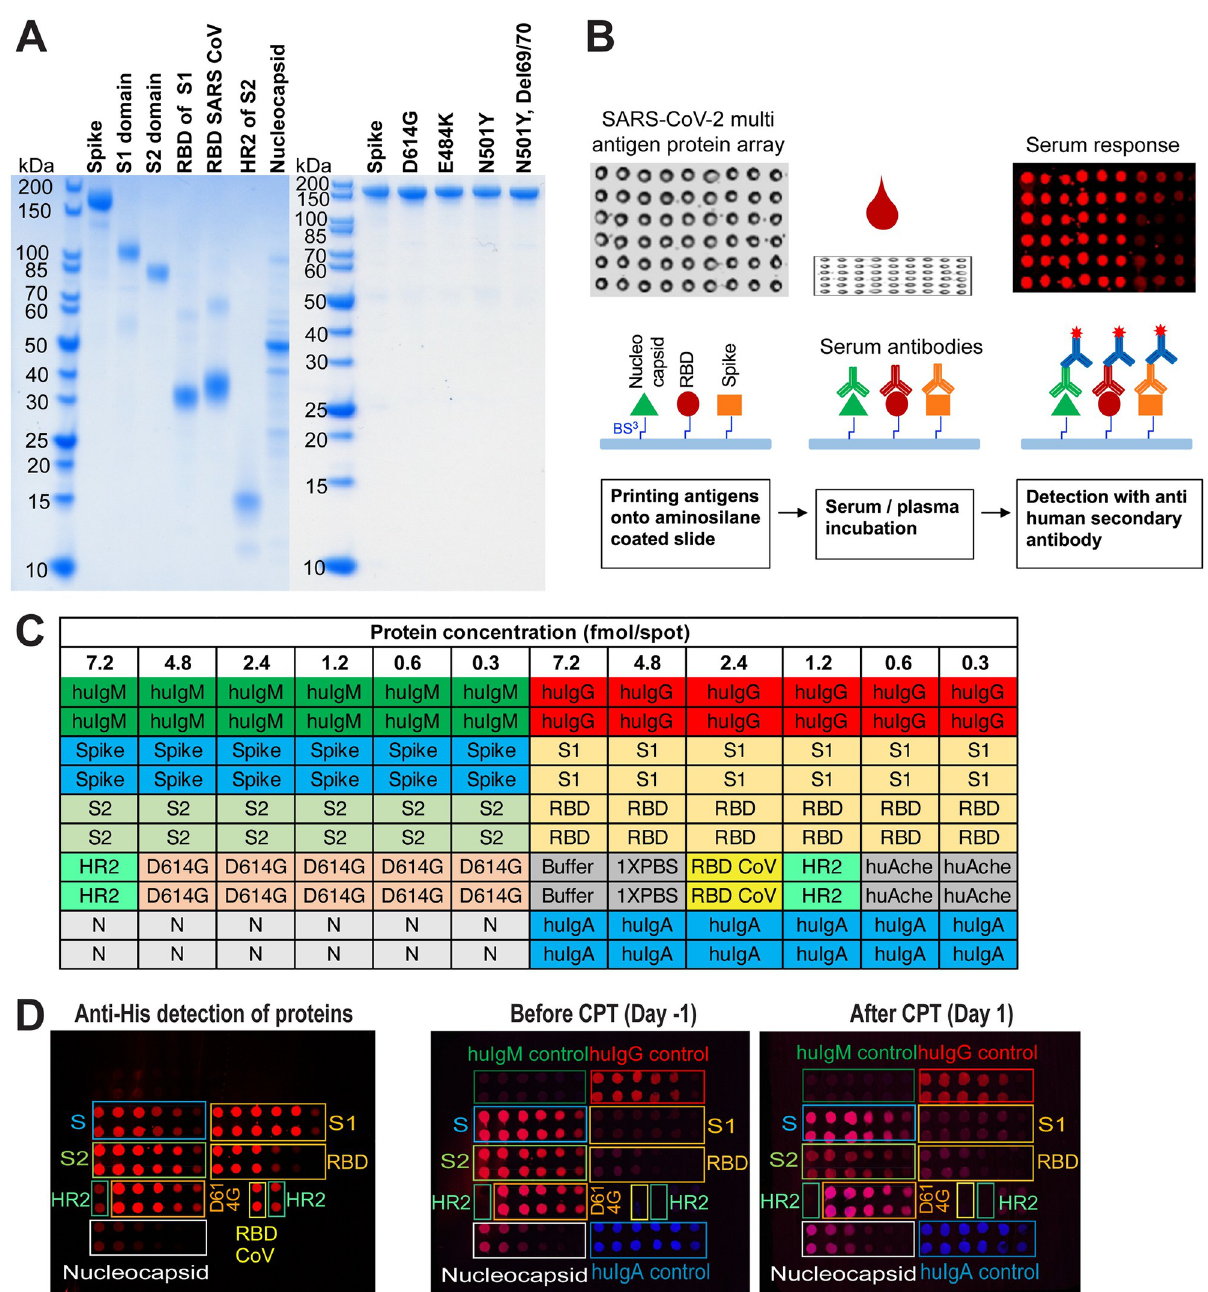
Fig 1. SARS-CoV-2 multi-antigen protein array production and processing. (A) Purified array proteins analyzed by SDS-PAGE under reducing conditions. (B) Schematics of workflow. (C) A representative protein array template showing SARS-CoV-2 antigen target proteins, human immunoglobulin controls (huIgM, huIgG, huIgA), buffer and negative controls along with the protein amounts and duplicates of each sample. (D) Anti-his staining of antigen target proteins immobilized on the microarray slide, and serum antibody detection of a COVID-19 patient one day before (Day -1) and one day after (Day 1) convalescent plasma transfusion using secondary antibodies for IgG (red) and IgA (blue) (two-color image). huIg control proteins do not have his tags; N, nucleocapsid; S, spike protein.